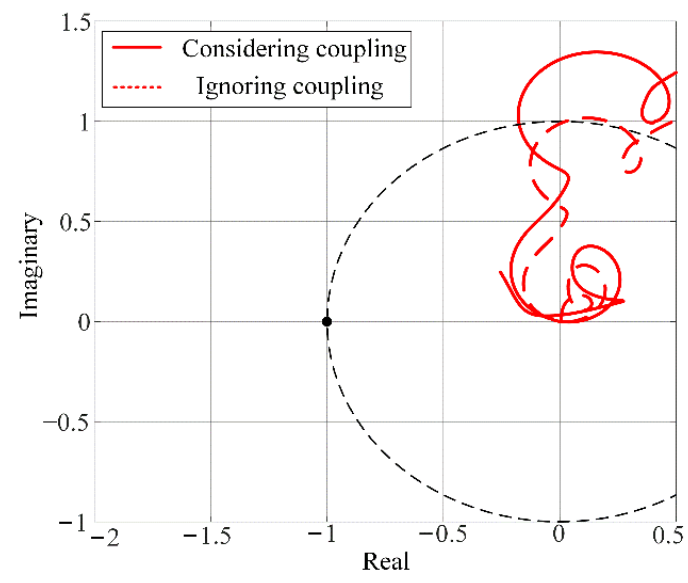
Figure 15. Nyquist plot of the impedance ratio Z g ( s ) Y MMC ( s ) with CCSC, SCR = 1.5. For this case, the phase current controller, CCSC, and PLL are adopted in MMC.